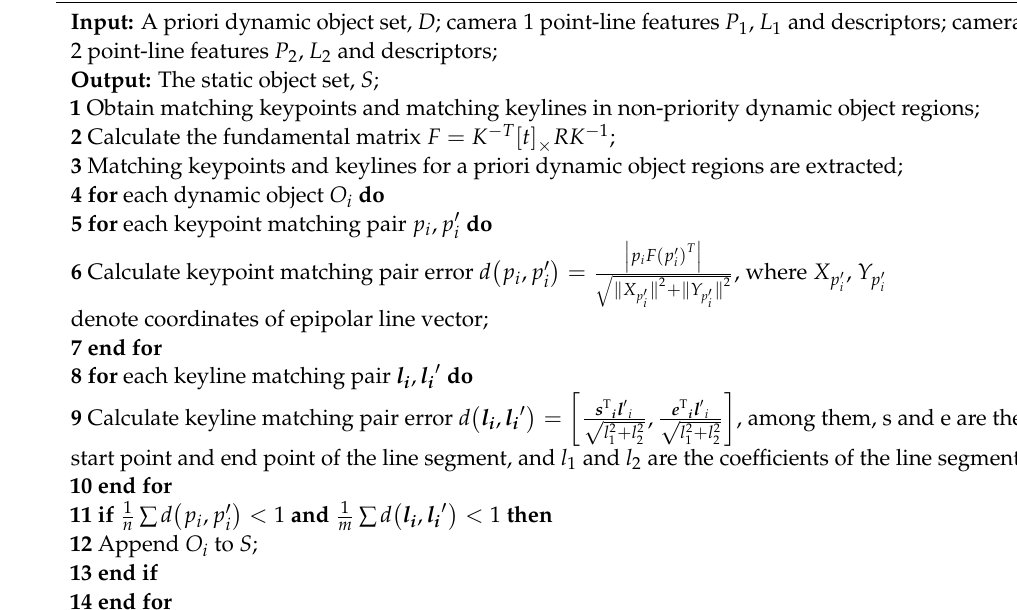
Algorithm 1: A priori dynamic object